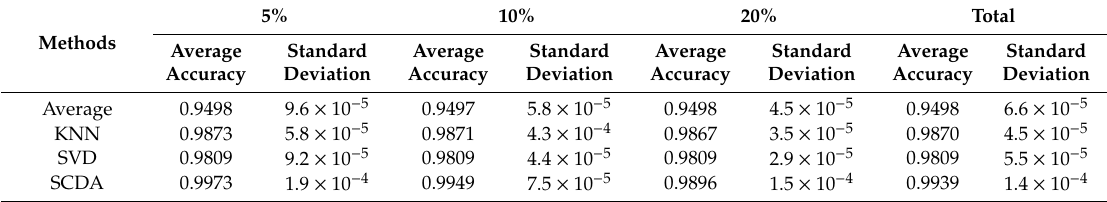
Table 4. Performance comparison on HLA genotypes of EAS super population at three missing scenarios. Table 5. Performance comparison on HLA genotypes of the five super populations at three missing scenarios.